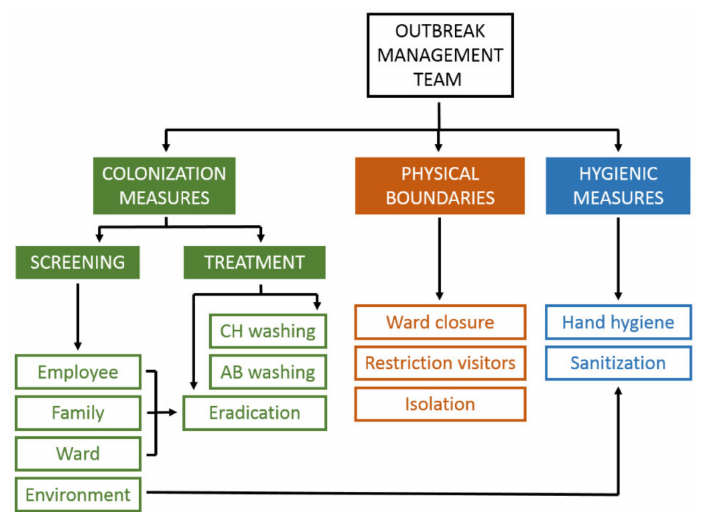
Figure 5. Outbreak containment strategies.Colonization measures and physical boundaries are especially relevant in case of methicillin-resistant Staphylococcus aureus . CH = chlorhexidine; AB =